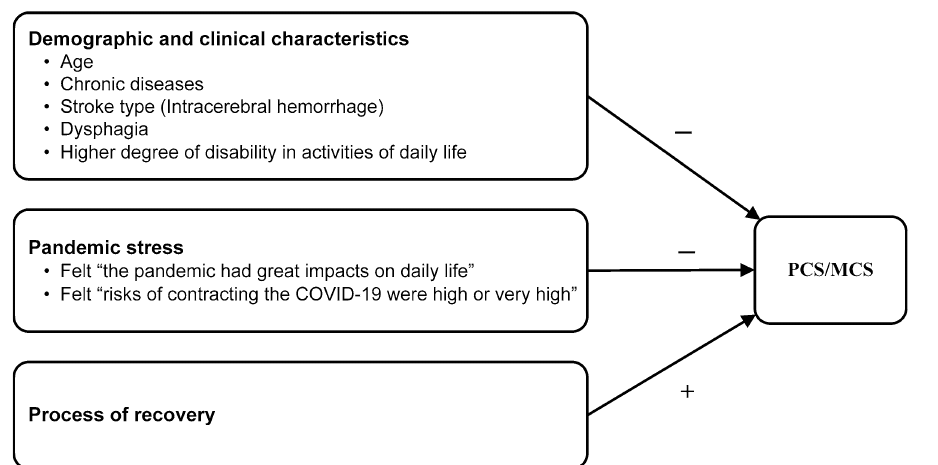
Figure 4. Variables associated with stroke patients’ QOL during the COVID-19